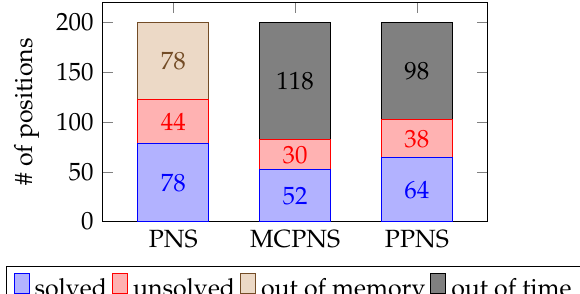
Figure 4. Number of Connect Four positions solved, unsolved, and out of bounds by proof number search (PNS), Monte Carlo proof number search (MCPNS), and probability-based proof number search